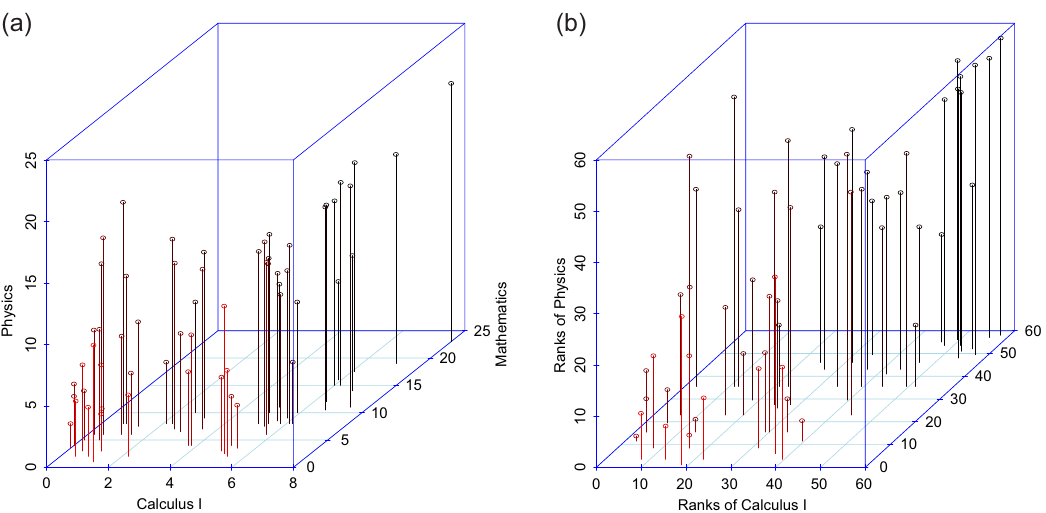
Figure 6. Data of 2015. (a) Scatterplot between Calculus I, Mathematics and Physics, from red to black color in increasing order in relation to the “ Mathematics ” axis. (b) Scatterplot between ranks of Calculus I , ranks of Mathematics and ranks of Physics , from red to black color in increasing order in relation to the “ Ranks of Mathematics ” axis.